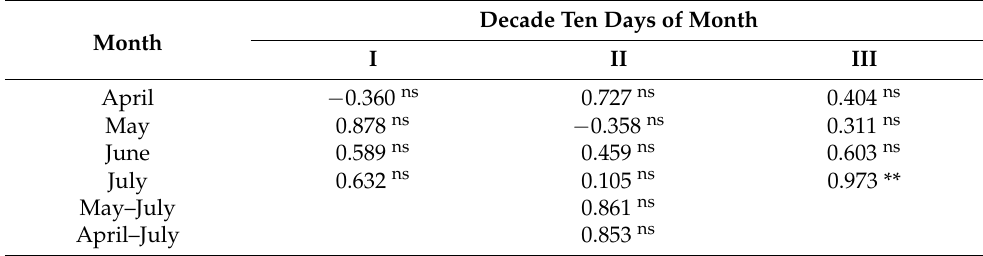
Table 4. Pearson correlation coefficients (r) for the total precipitation in months, the entire pea vegetative period, and seed yield. Decade Ten Days of Month I